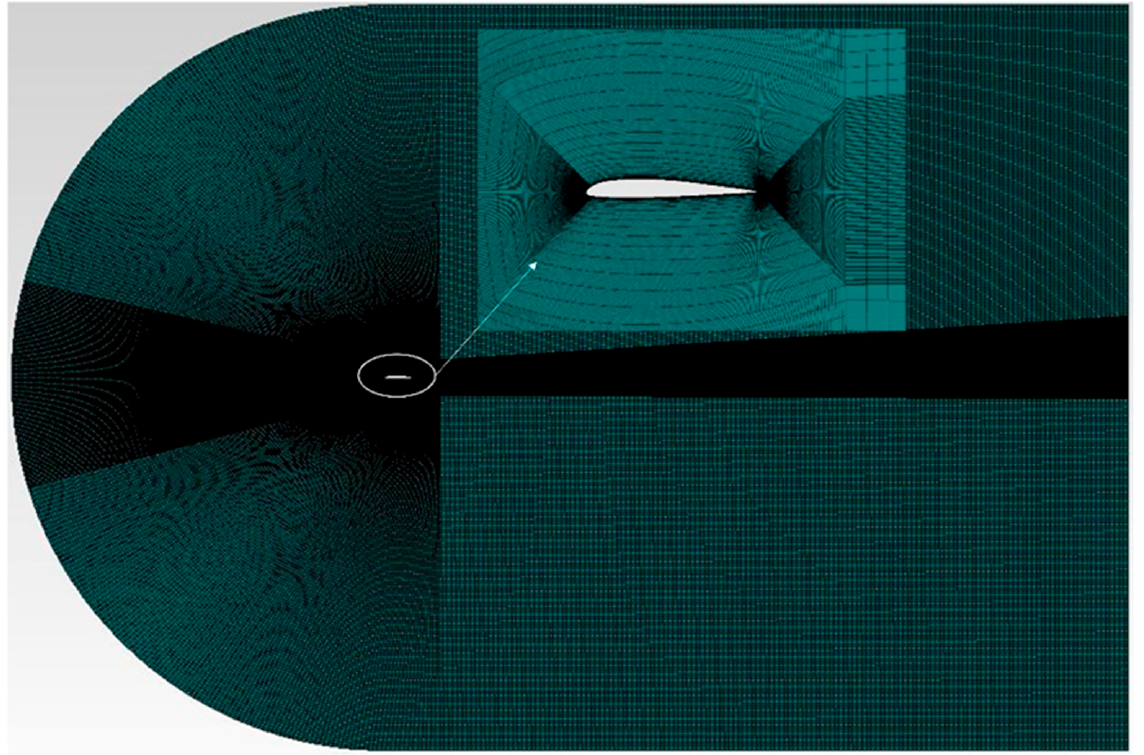
Figure 10. Grid generation of a morphing leading-edge airfoil.